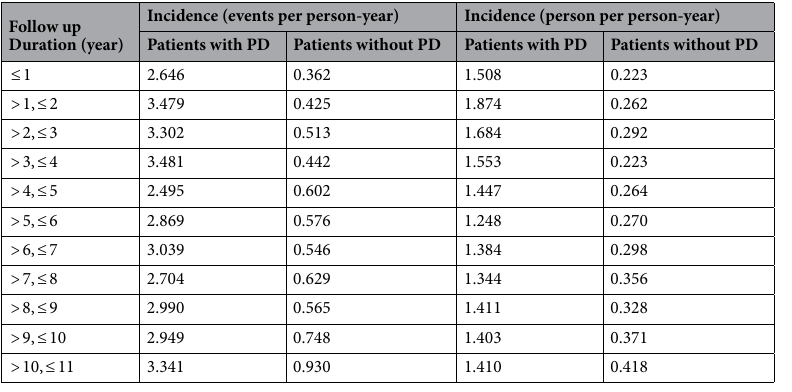
Table 2. Incidence of aspiration pneumonia among PD patients and control groups in each year. PD Parkinson’s disease.